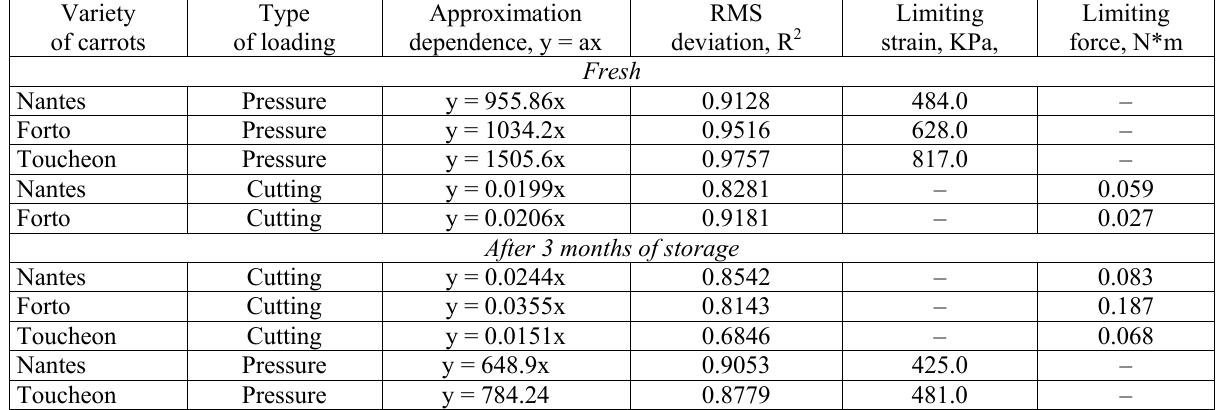
Table 1. Strength characteristics of carrots Variety of carrots